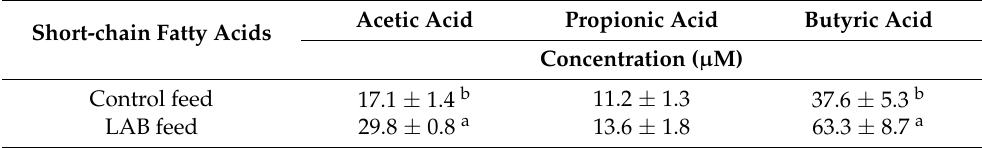
Table 5. The level of intestinal short chain fatty acid in L. vannamei shrimp fed with LAB feed- contained L. fermentum